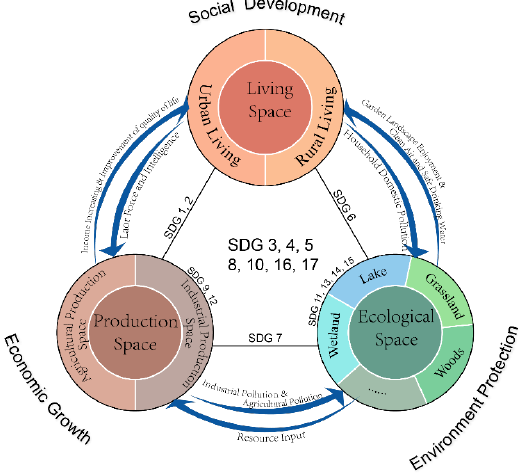
Figure 1. The relationship of PLE space and SDGs.